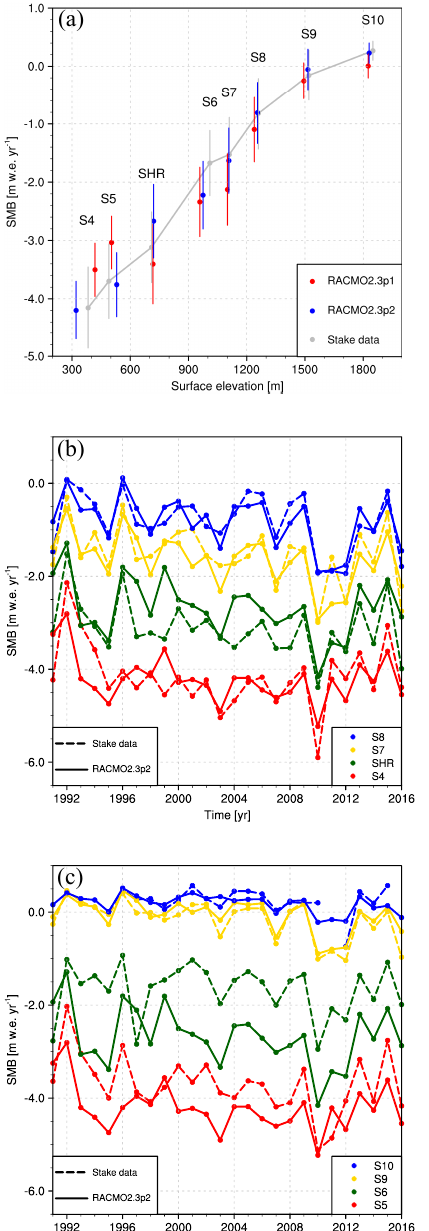
Figure 9. (a) Observed and simulated SMB (mw.e.yr − 1 ) along the K-transect in western Greenland (67 ◦ N), averaged for the period 1991–2015. The observed SMBs (grey dots) at S4, S5, SHR, S6, S7, S8, S9 and S10 are based on annual stake measurements; S10 obser- vations cover 1994–2015. The coloured bars represent the standard deviation (1 σ ) around the 1991–2015 modelled and observed mean value. Modelled SMB at stake sites are displayed for RACMO2.3p2 (blue dots) and RACMO2.3p1 (red dots). Panel (b) shows time se- ries of modelled (continuous lines) and observed (dashed lines) an- nual SMB at stakes S4, SHR, S7 and S8 for the period 1991–2016. Similar time series are shown for S5, S6, S9 and S10 in panel (c) . At S10, modelled SMB is estimated as the difference between total precipitation and melt.